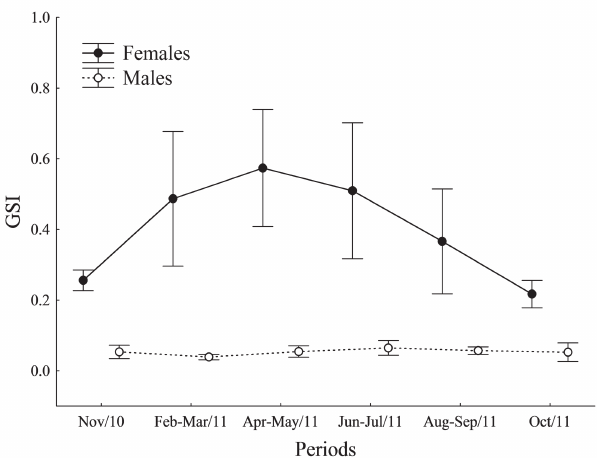
Fig. 5. Variation in reproductive effort of Cichla piquiti over time (mean ±SE), measured as the gonad-somatic index (GSI, %) calculated separately for males and females. Energy allocation. For immature fish, covariance analysis showed no variation in body condition and fat accumulation among periods and sexes (Table 4), indicating the absence of temporal trade-offs in energy use (Fig. 6a, c). For adults, covariance analysis showed no variation in body condition (Fig. 6b), but fat accumulation varied significantly among periods and sexes (Table 4). In the case, adult fish accumulate more fat in the late dry and early rainy seasons (October), and females accumulated more fat than males (Fig.